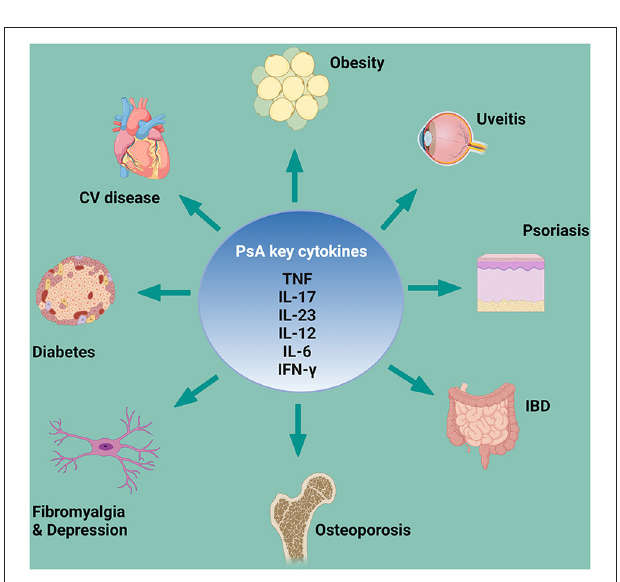
FIGURE 1 | PsA key cytokines involved in comorbidities and EAMs pathogenesis. CV, cardiovascular; EAM, extra-articular manifestation; IBD, inflammatory bowel disease; IFN- γ , interferon; IL, interleukin; PsA, psoriatic arthritis; TNF, tumor necrosis factor. Created with Biorender.com